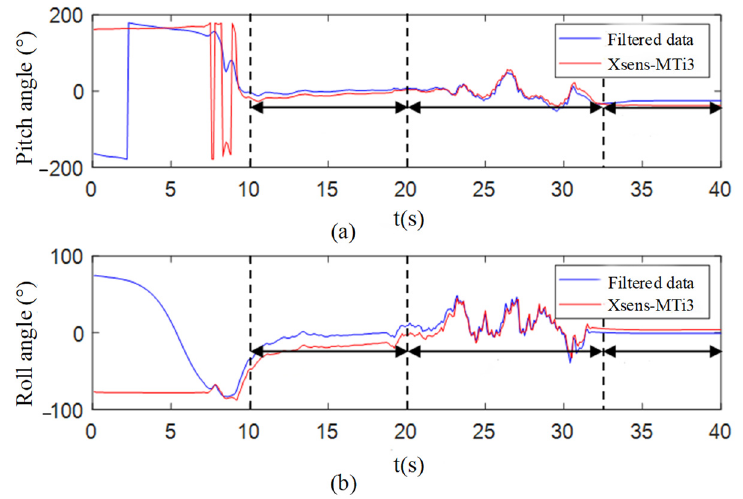
Figure 14. Comparison diagram of attitude solution. ( a ) Comparison of pitch angle changes. ( b ) Comparison of rolling angle changes.